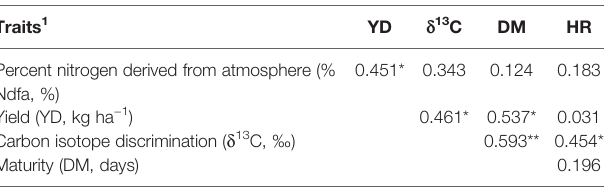
TABLE 4 | Correlations matrix identi fi ed among fi ve traits measured in 20 common bean genotypes evaluated at the Elora research station (ON) on N-poor soil in 2016 pilot study using LSmeans data, N =